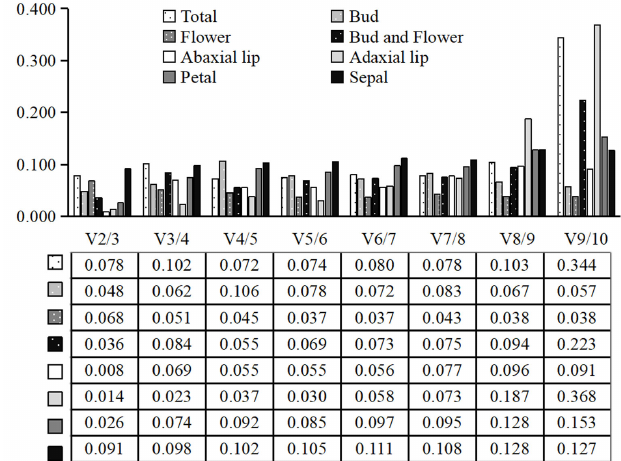
Figure 4. Optimal number of reference genes in different groups calculated by geNorm. The pairwise variation (Vn/Vn + 1) was analyzed between normalization factors (NFn and NFn + 1). The Vn/n + 1 threshold is 0.15. If Vn/n + 1 is lower than 0.15, n reference genes can meet the experimental requirements, otherwise n + 1 reference genes should be used for further study.